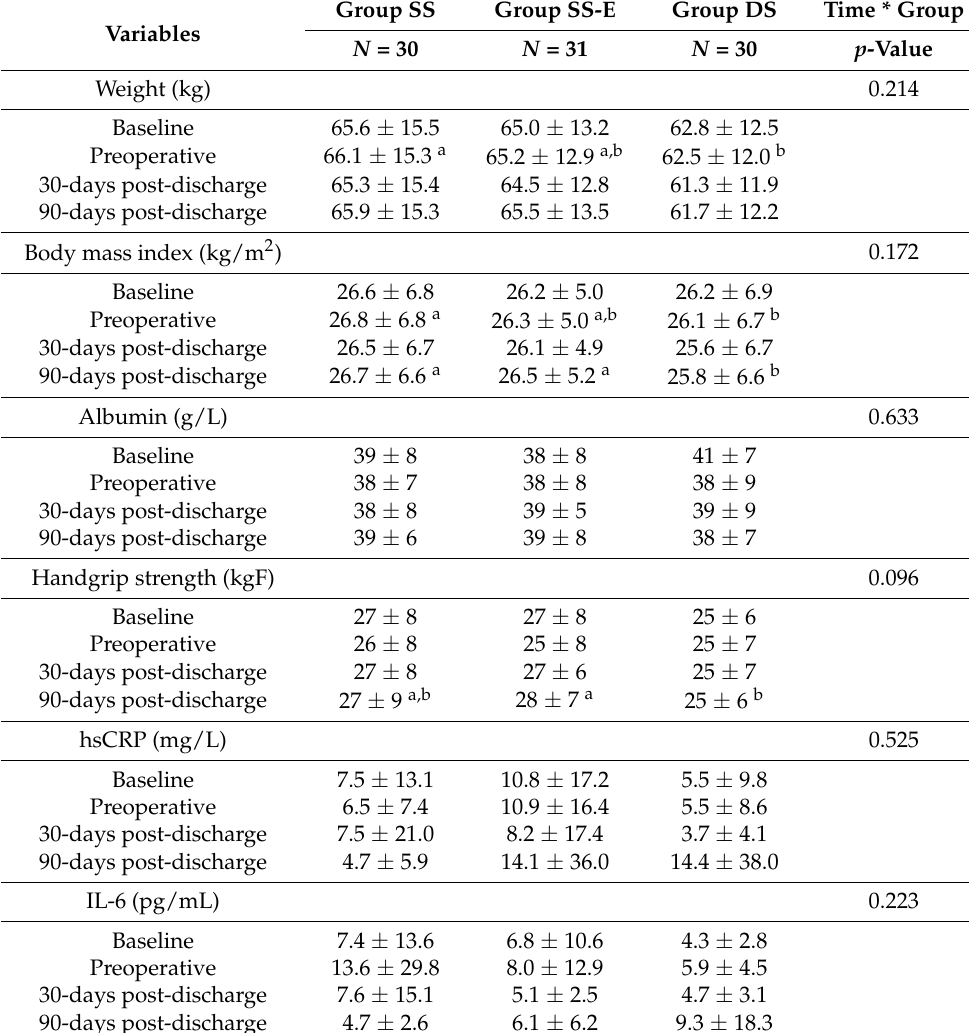
Table 4. Evaluation of primary and secondary outcomes between